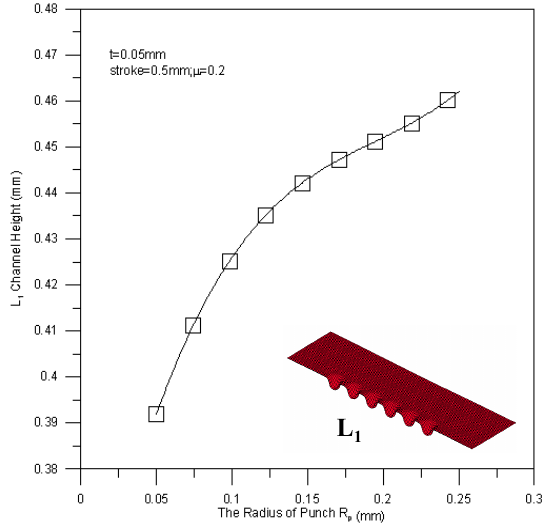
Figure 18. The relationship between the tool radius and the channel height of the L 1 section.